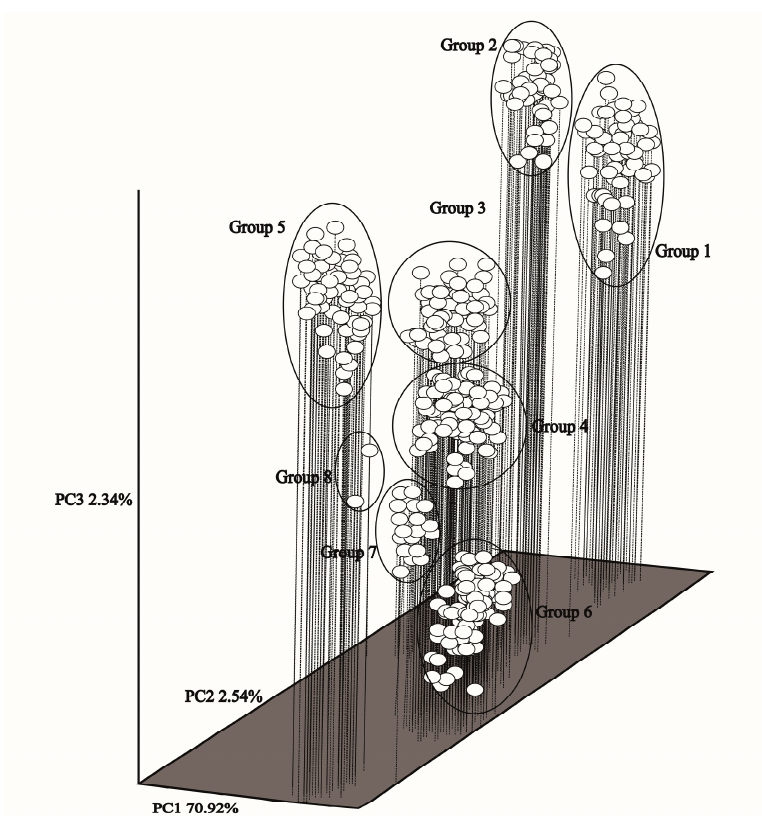
Figure 2. Principle coordinate analysis of 430 Chinese C. dactylon accessions based on the genetic similarity matrix derived from the combined data of SRAP